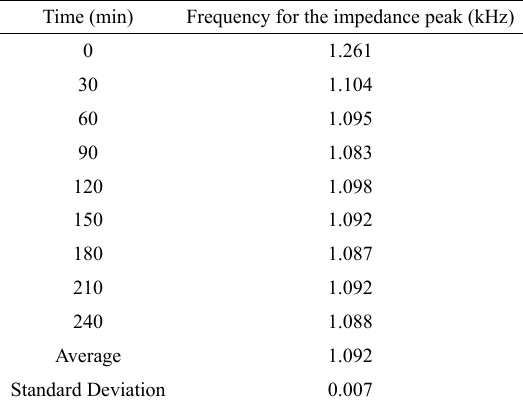
Figure 8. Frequency scanning from 0.9 to 1.3kHz for the Araldite ® LY5052/Aradur5052 TM epoxy system under isothermal cure at 80°C. results. It can be noticed that the frequency values for the best impedance response obtained by this second scanning are very close to the ones obtained in the first scanning. These values are summarized in Table 3. Table 3. Frequency peak values obtained from the 0.9 to 1.3kHz frequency scanning.